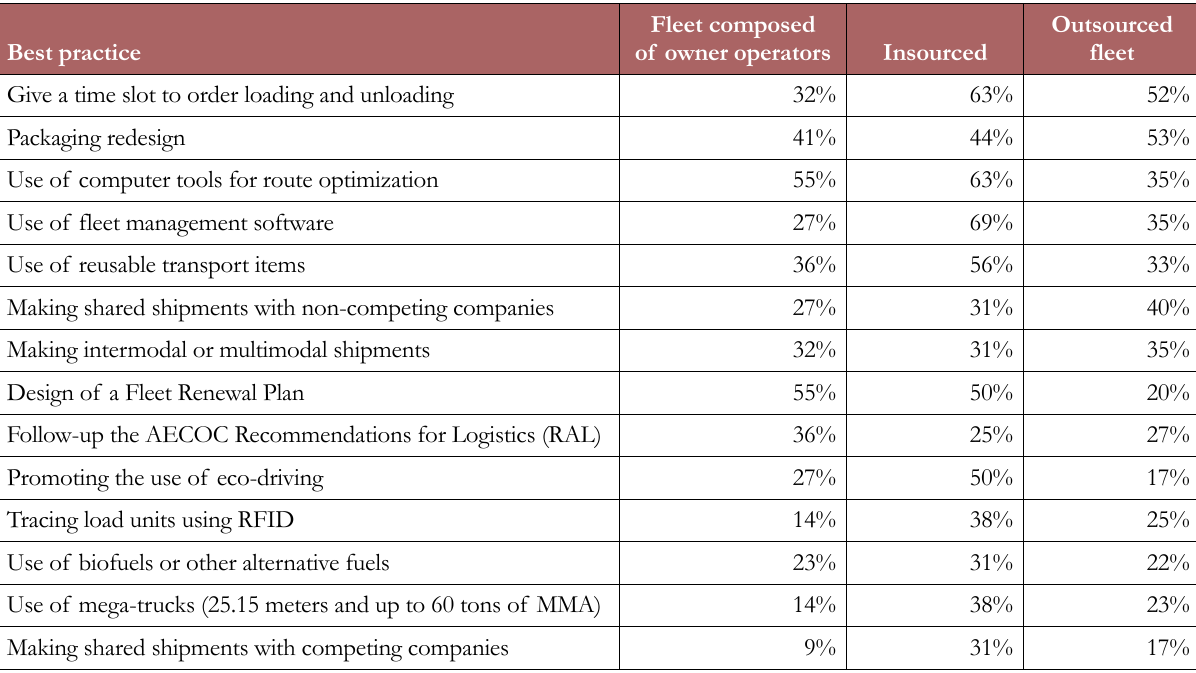
Table 2. Use of best practices by type of